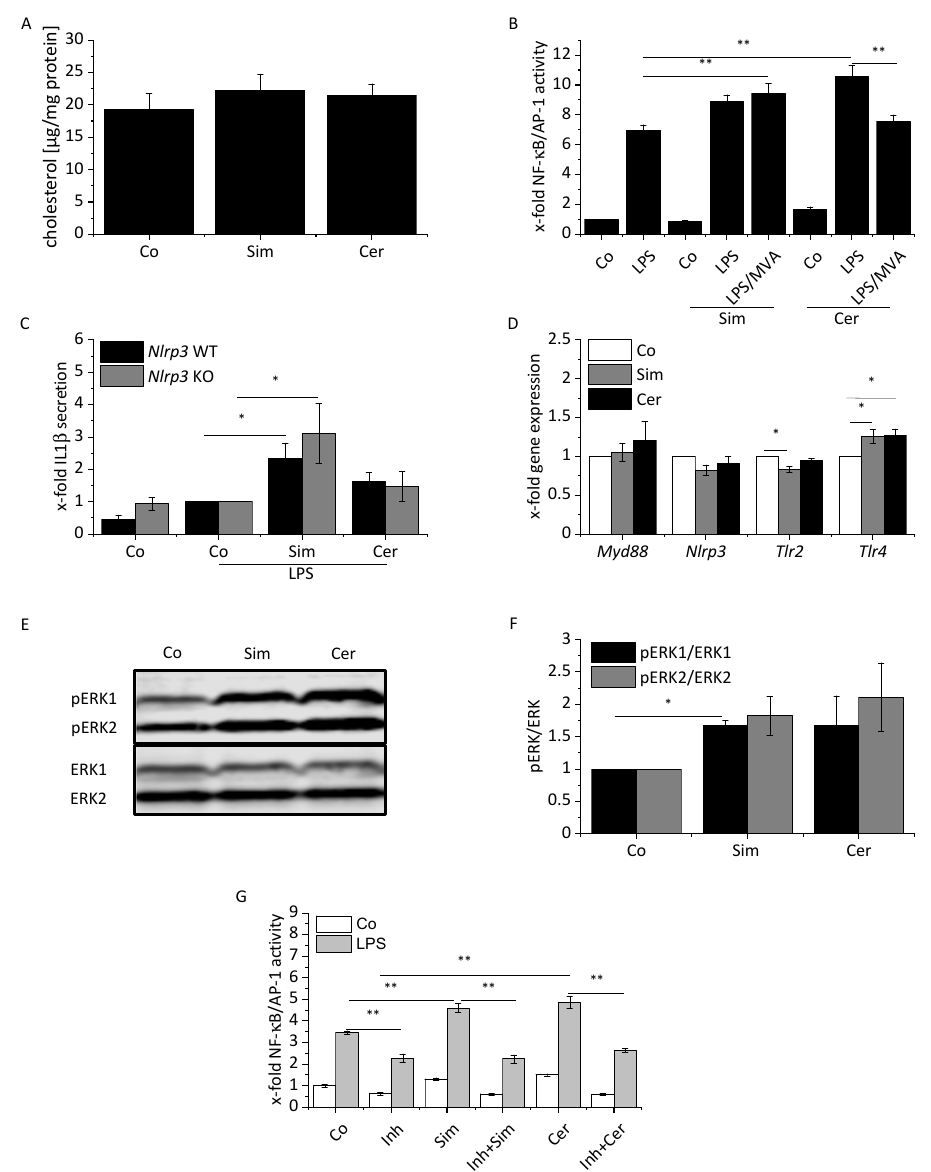
Figure 4. Statins affect different signaling pathways in macrophages. ( A ) Intracellular cholesterol levels. BMMs were either treated for 24 h with simvastatin (Sim, 2 µ M) or cerivastatin (Cer, 0.5 µ M). Co = solvent control ( n = 3, triplicates). ( B ) RAW-Blue TM cells were treated for 24 h with either Sim (2 µ M) or Cer (1 µ M). Cells were co-treated with mevalonate (MVA, 100 µ M) where indicated. Inflammatory activation was induced by treatment with LPS (100 ng/mL) for the final 4 h. NF- κ B/AP-1 activity was determined by secreted embryonic alkaline phosphatase (SEAP) detection. Co = solvent control ( n = 3, triplicates). ( C ) IL1 β was measured by bioassay. BMMs of Nlrp3 WT and KO BMMs were treated for 24 h with either Sim (2 µ M) or Cer (0.5 µ M). Inflammatory activation was induced by treatment with LPS (100 ng/mL) for the final 4 h. Co = solvent control ( n = 4 each WT and KO, quadruplicates). ( D ) mRNA expression of indicated genes were determined by real-time RT-PCR, normalized to Ppia , and expressed as x-fold of Co. BMMs were either treated for 24 h with Sim (2 µ M) or Cer (0.5 µ M). Co = solvent control ( n = 6). ( E , F ) ERK phosphorylation was examined by Western Blot analysis. BMMs were treated with Sim (2 µ M) or Cer (0.5 µ M) for one hour. Co = solvent control. ( E ) One representative blot is shown. ( F ) Signal intensities were quantified and normalized to total ERK ( n = 3). ( G ) RAW-Blue TM cells were pre-treated for 30 min with the ERK inhibitor PD98059 (Inh, 10 µ M). Cells were treated for 24 h with either Sim (2 µ M) or Cer (1 µ M). Inflammatory activation was induced by treatment with LPS (100 ng/mL) for the final 4 h. NF- κ B/AP-1 activity was determined by secreted embryonic alkaline phosphatase (SEAP) detection. Co = solvent control ( n = 3, triplicates). One-sample t -test followed by Bonholm post hoc test was used for analyzing gene expression data of the control group and Western blot ( D , F ). Means of more than two groups were compared by one-way ANOVA with Bonholm post hoc test (normal distribution) ( B , C , G ). * p < 0.05, ** p <